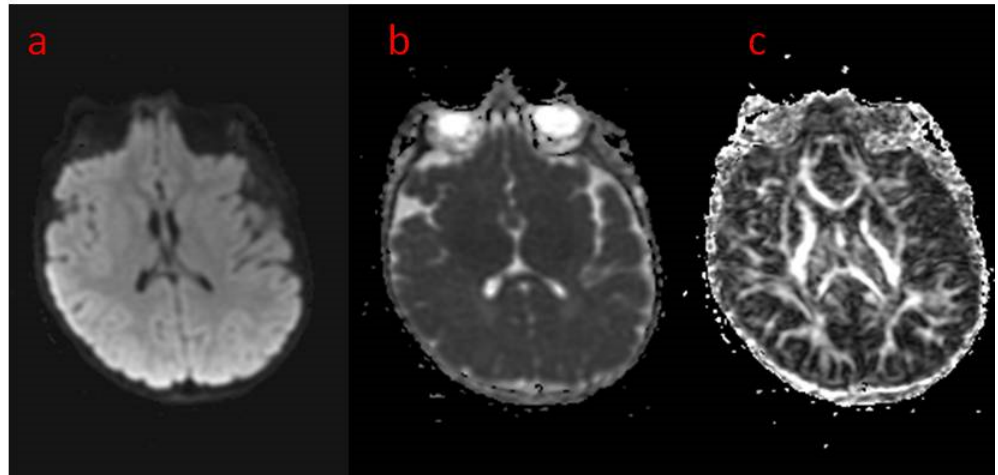
Figure 2. ( a – c ) Brain MRI, axial ( a ) T2 FLAIR ( b ) T2, coronal (T2) unfinished myelinisation of white matter surrounding occipital horns